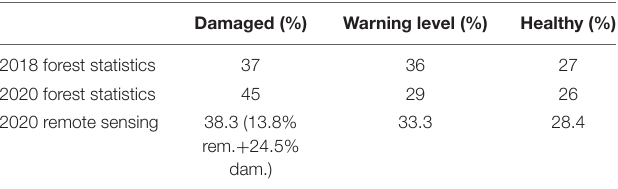
TABLE 1 | Fractions of classified spruce health conditions by the forest statistics and by the proposed remote sensing approach. Damaged (%) Warning level (%)